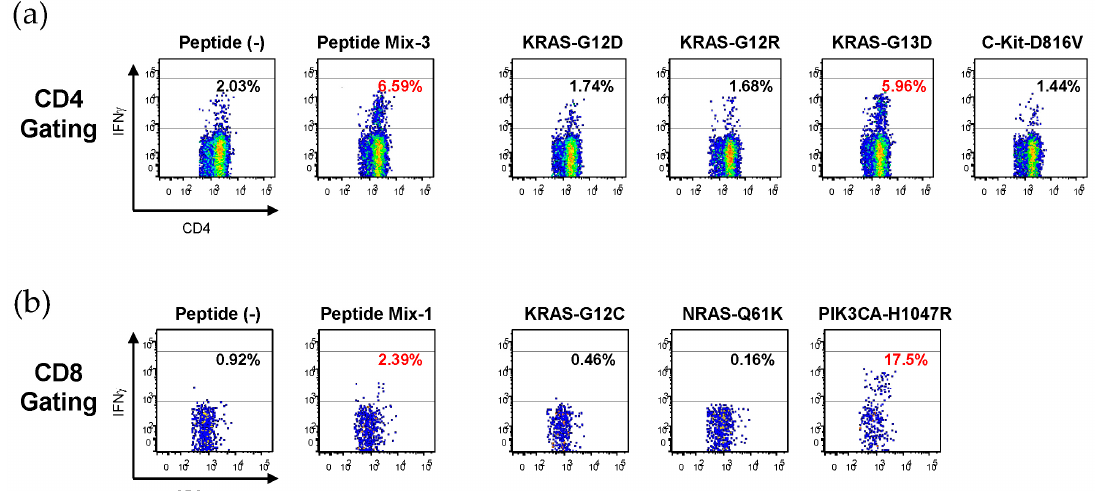
Figure 1. Representative flow cytometry profile of IFN γ production in CD4 + and CD8 + T cells. ( a ) Mix-3-stimulated CD4 + T cells (donor No. 21) were first examined for responses to the Mix-3, and then to each peptide constituent of the Mix-3. The percentages of IFN γ positive cells in CD4 + T cells are shown. ( b ) Mix-1-stimulated CD8 + T cells (donor No. 24) were first examined for responses to the Mix-1, and then to each peptide constituent of the Mix-1. The percentages of IFN γ positive cells in CD8 + T cells are shown.